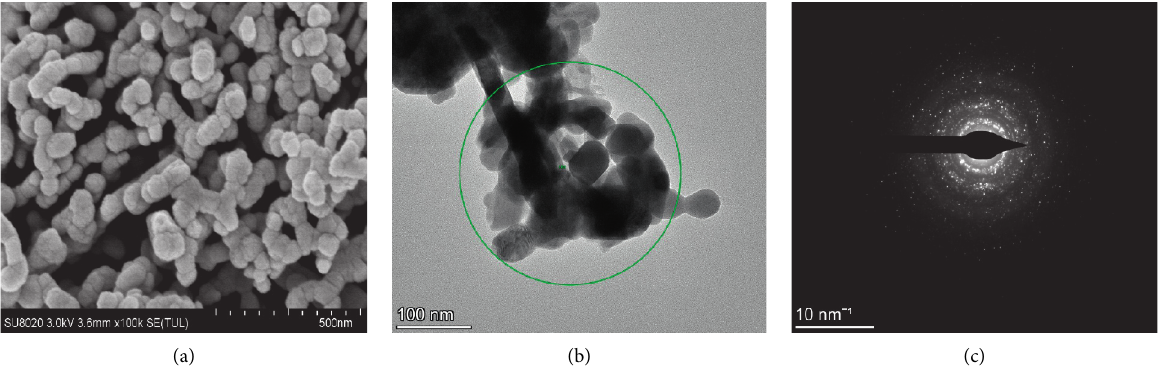
Figure 2: (a) SEM images of nano-Sm 2 O 3 ; (b) TEM images of nano-Sm 2 O 3 ; (c) SAED of nano-Sm 2 O 3 .